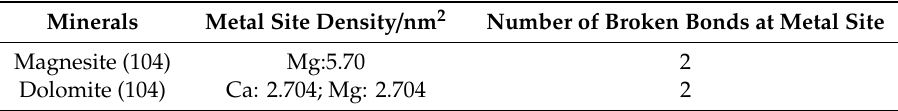
Table 2. Metal site properties of (104) planes of magnesite and dolomite.